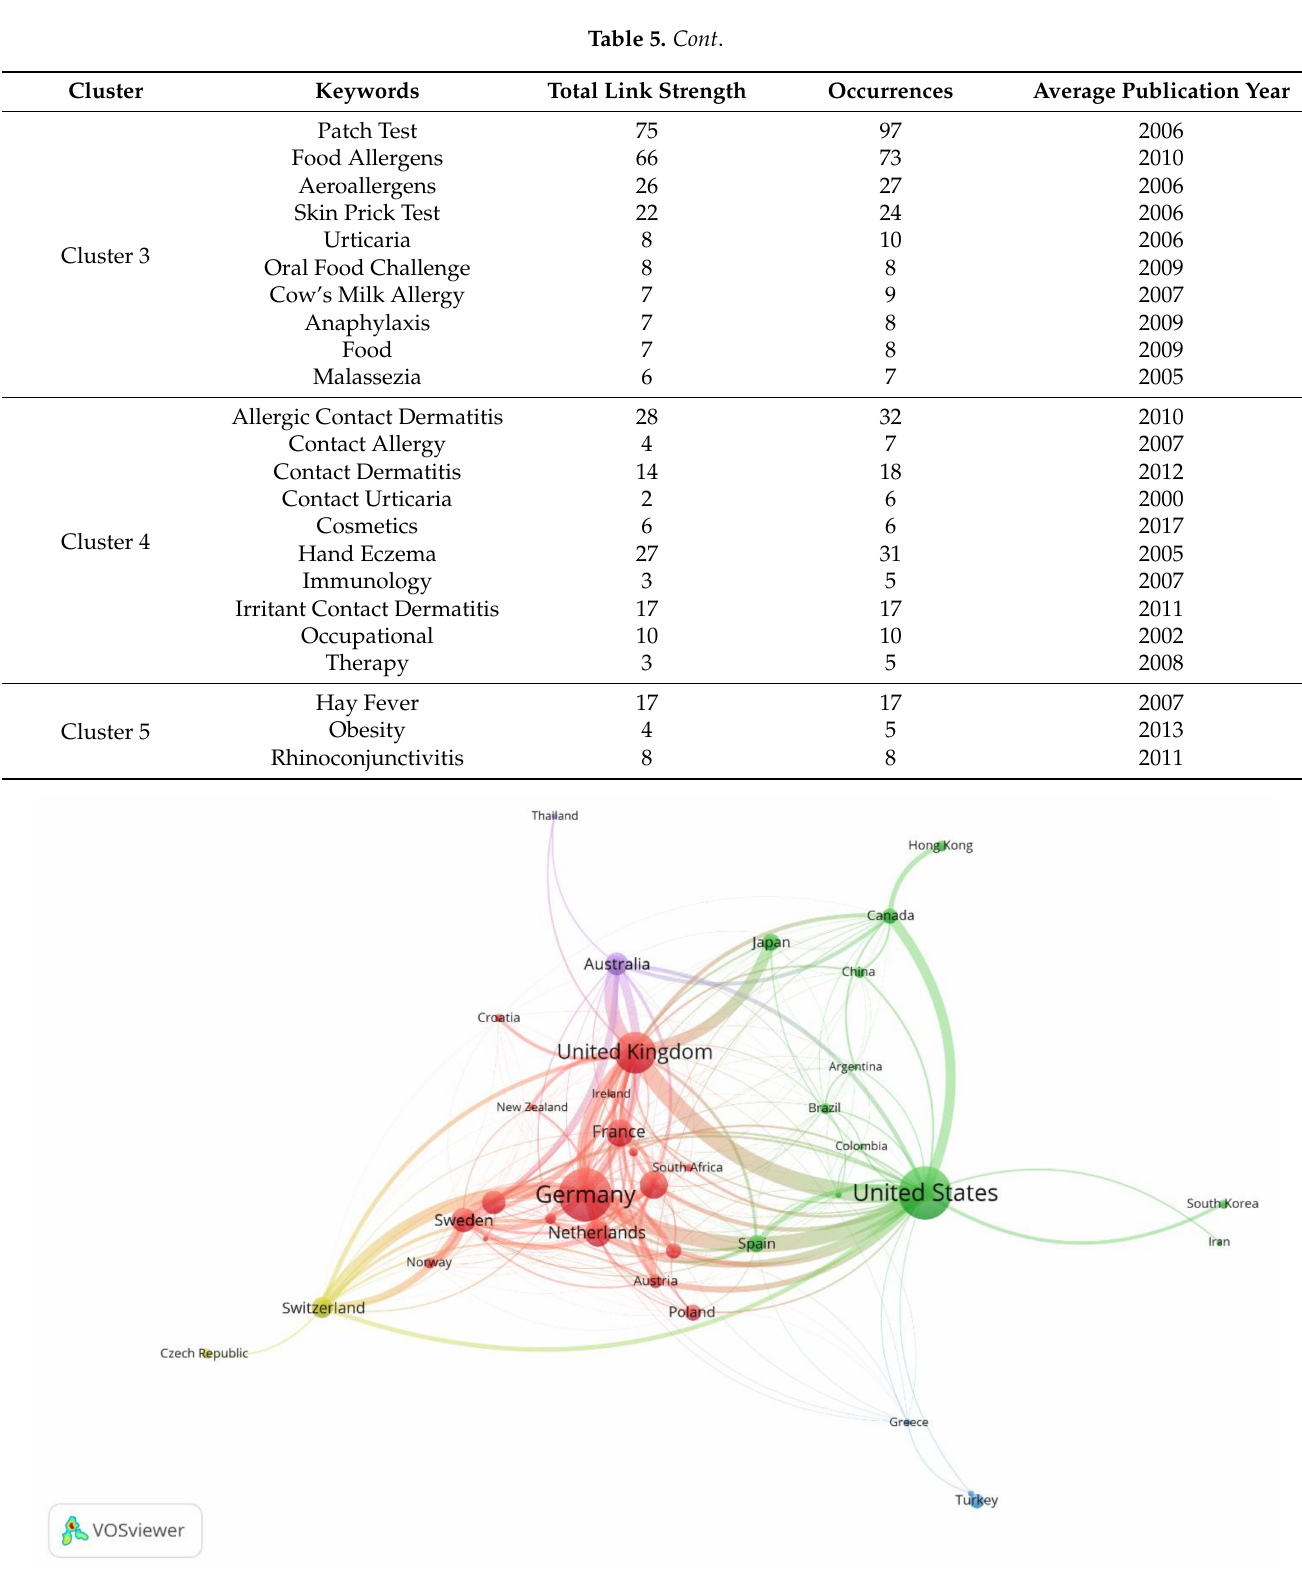
Figure 4. Co-authorship networks of countries during the period 1990–2020. Organizations that published more than five articles were included in the co-authorship network analysis. The following parameters for VOSviewer were used: layout attraction of 3, clustering resolution of 0.5, visualization scale of 1.3, and size variation of 0.6; the node sizes were weighted based on the number of documents. Five clusters were identified. The USA, the UK, and Germany were central hubs of collaborative